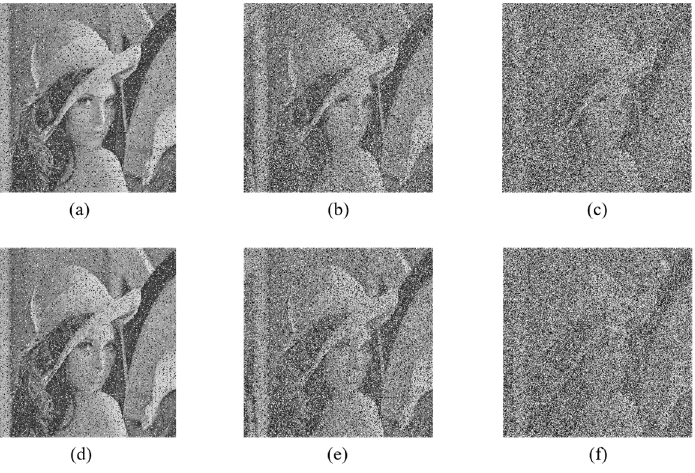
the proposed method has better anti-cropping ability.